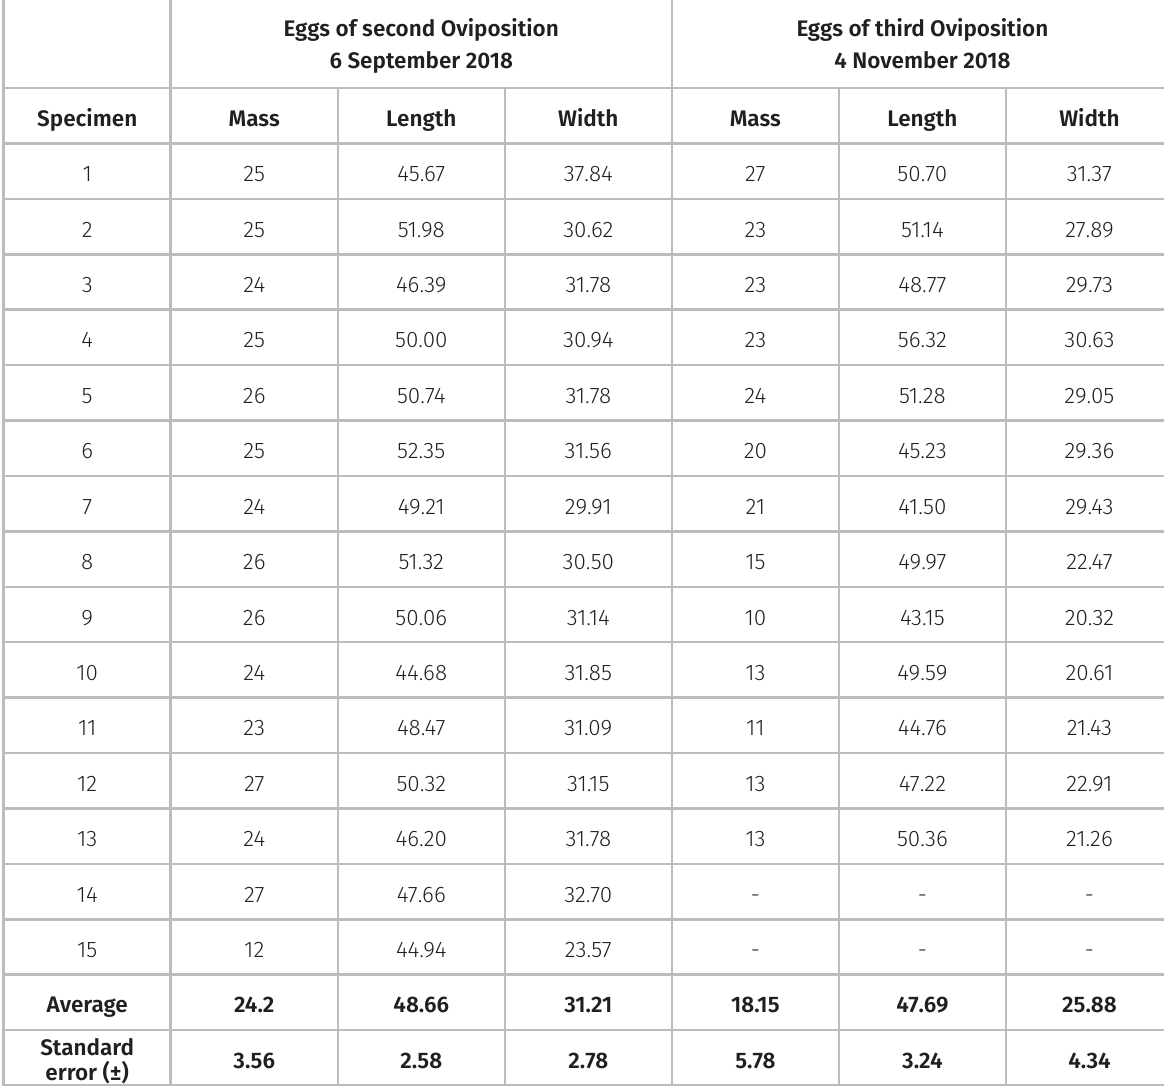
Table I. Measurements collected from the eggs of second and third ovipositions of Boiruna sertaneja from Campina Grande, PB, Brazil. Mass is provided in grams (g) and morphometrical data are provided in millimeters (mm). Length = measurement at the longest point of the egg, Width = measurement at the widest point of the